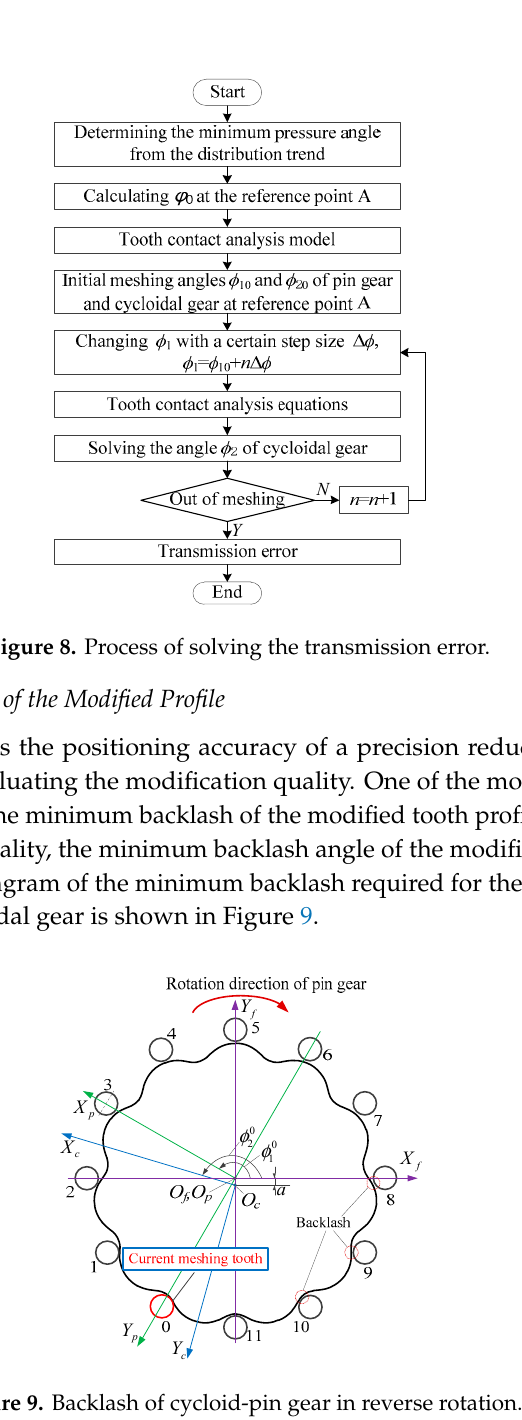
Figure 9. Backlash of cycloid-pin gear in reverse rotation.